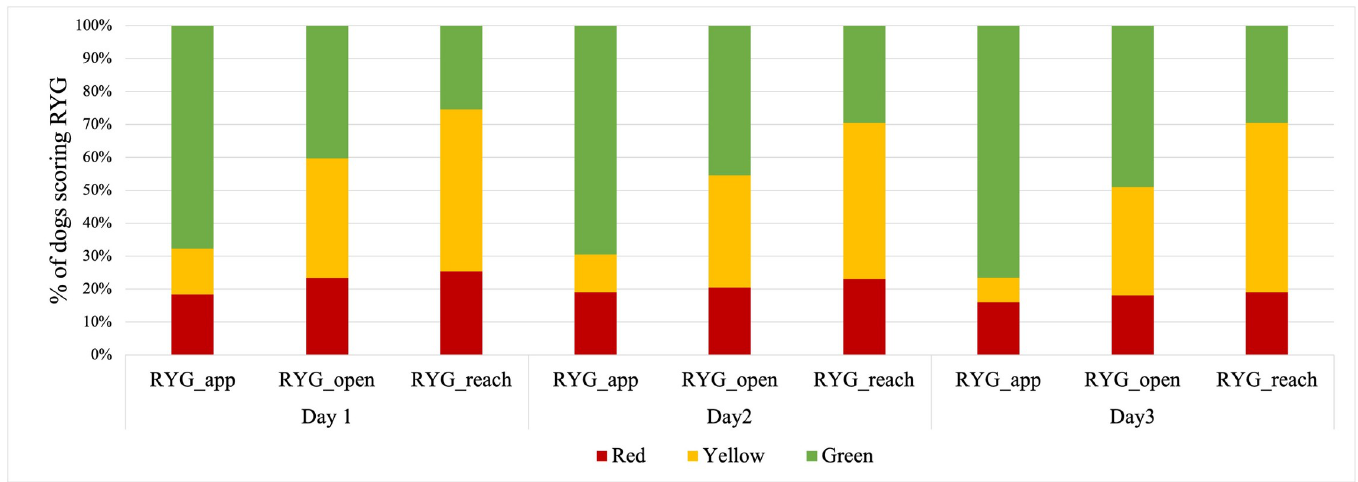
Fig 2. Dog response to the three phases of the approach test. Approach (RYG_app), open door (RYG_open), and reach (RYG_reach) scores using the RYG (Red, Yellow, Green) method (see main text for details) across three consecutive days.